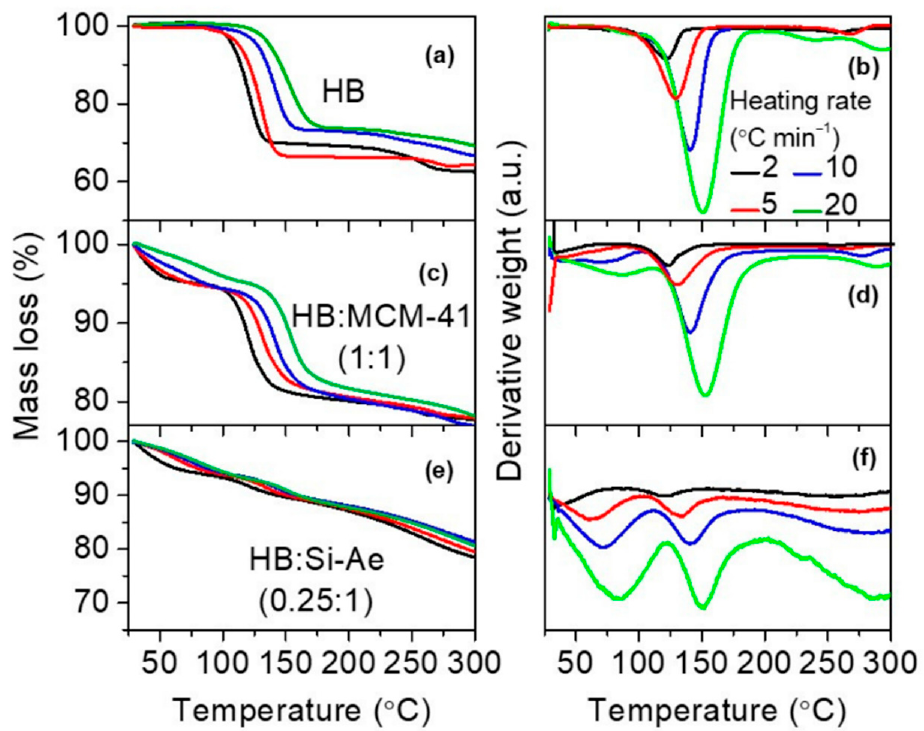
Figure 6. TGA and corresponding DTG of bulk HB ( a , b ), HB:MCM-41(1:1) ( c , d ) and HB: Si-Ae (0.25:1) ( e , f ) at various heating rate heating rates.